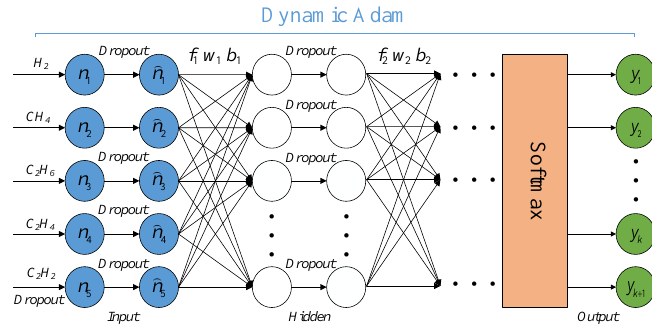
Figure 2. The instantiation model of